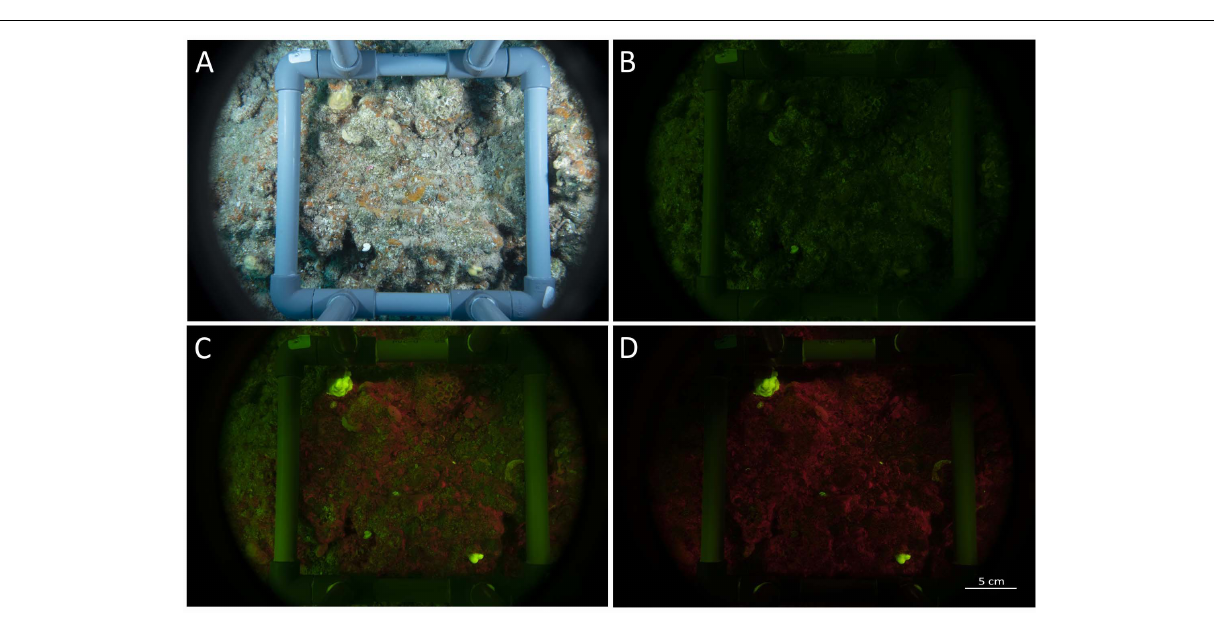
Another two points that are recommended when removing the ICF and using a barrier filter is to set the camera White Balance (WB) to 2300K or less and to